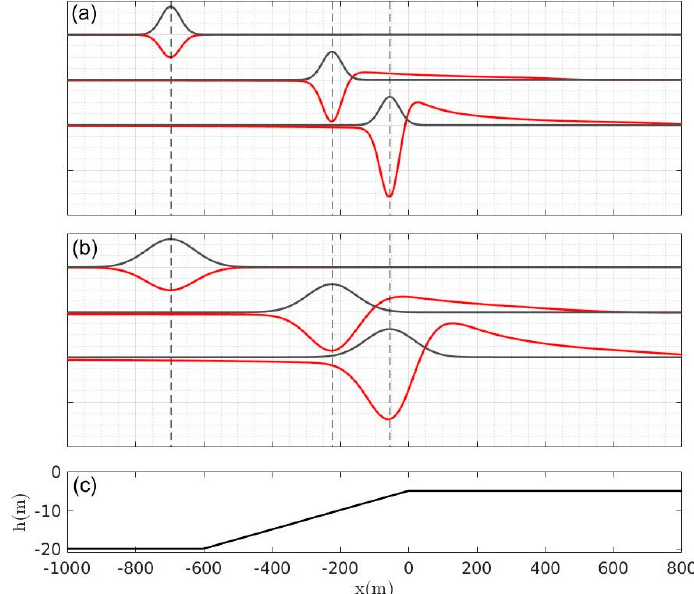
Figure 7. Spatial visualization of a short ( a ) and long ( b ) Gaussian-shape radiation stress (black line) and total long wave surface elevation (red) at di ff erent time instants and location over the bottom profile ( c ). The vertical dashed lines indicate the zero lag between forcing and bound wave.